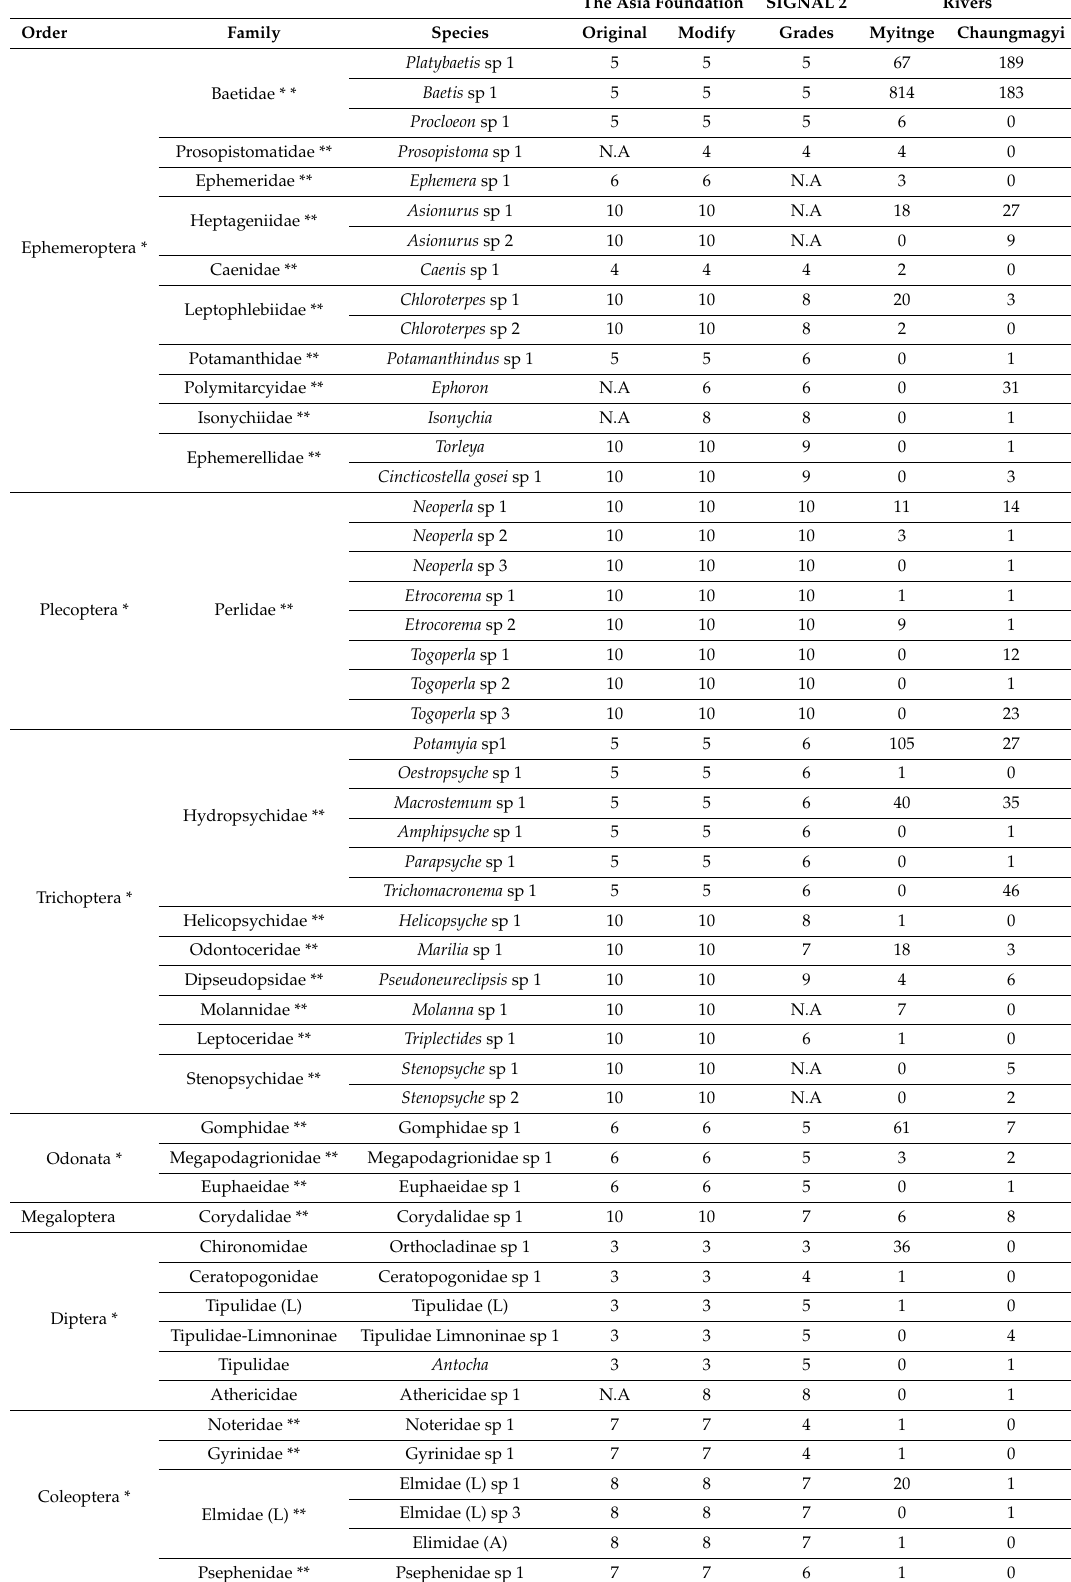
Table 2. Collected abundance and their original and modified scores of The Asia Foundation Index and Stream Invertebrate Grade Number Average Level (SIGNAL 2)